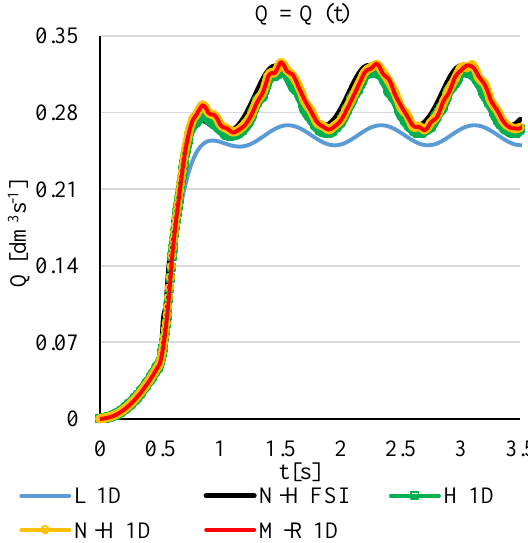
Fig. 6. Volumetric flow rates in the thin-walled